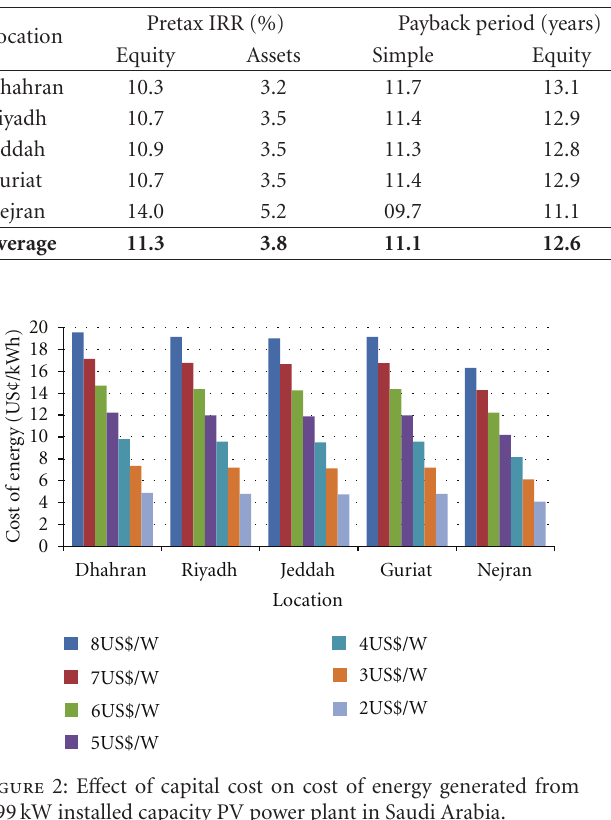
Table 6: Summary of internal rate of return (IRR) and cost of energy (COE) for all the stations considered in the present work.